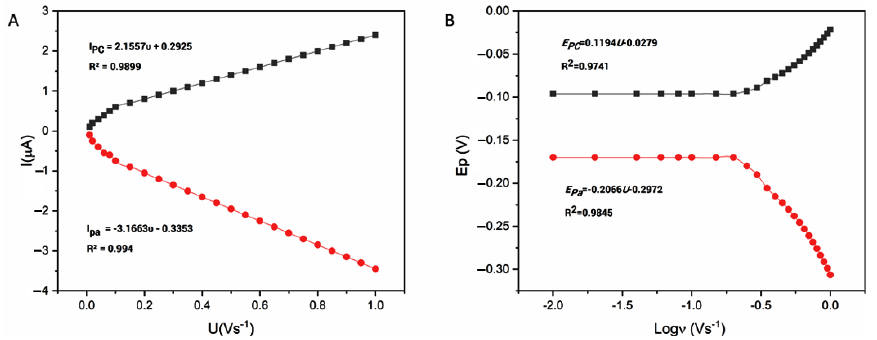
Figure 6. ( A ) The peak current against the scan rate of the SSt-g-PANI@G nanocomposite electrode